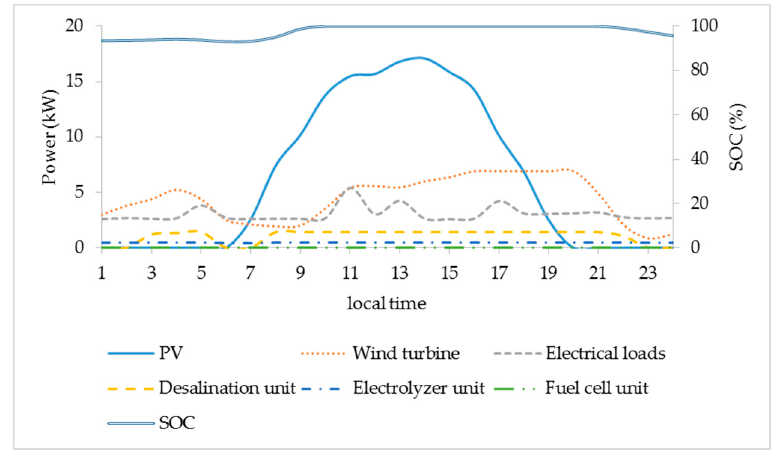
Figure 10. Power variations during the sunny day.